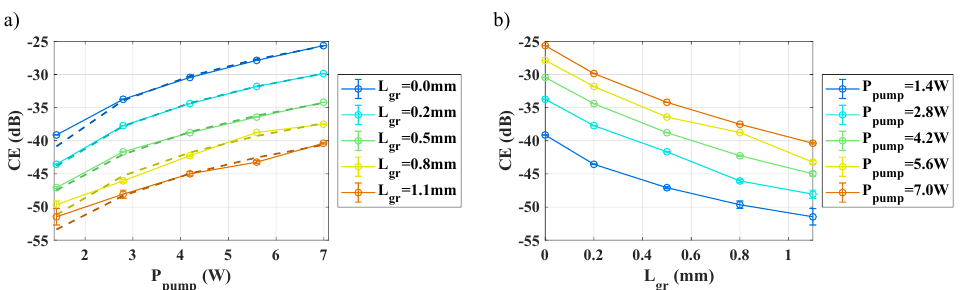
Figure 4. Measured CE (as per Equation (2), dB scale) as a function of ( a ) the coupled peak pump power, for different graphene lengths and with a quadratic fit (dotted line), and ( b ) the graphene length for different coupled peak pump powers. The coupled peak probe power is fixed at P probe = 7W. Error bars calculated from the spectrum noise are added, taking into account an error at (1 σ